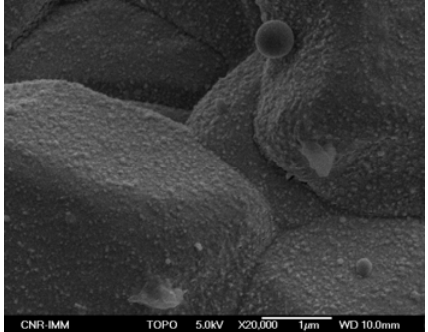
Figure 3. SEM micrographs of TiO rough alumina substrate.